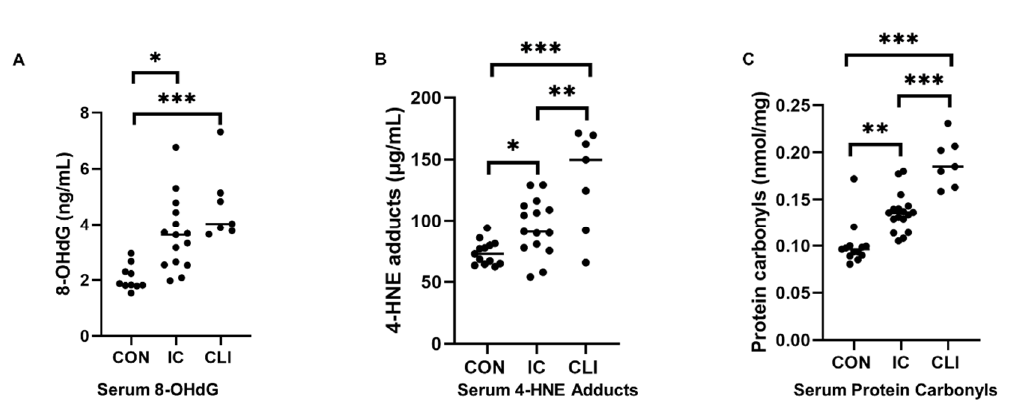
Figure 2. Levels of oxidative stress markers. Levels of markers of DNA, lipid, and protein oxidation were measured in the sera of patients with intermittent claudication (IC), critical limb ischemia (CLI), and non-PAD controls. ( A ), levels of 8-Oxo-2′-deoxyguanosine (8-OHdG); ( B ), levels of 4-hydroxynonenal (4-HNE); ( C ), levels of protein carbonyls. Bars indicate median, and p values were calculated by ANCOVA test. * represents p < 0.05, ** represents p < 0.01, *** represents p < 0.0001.